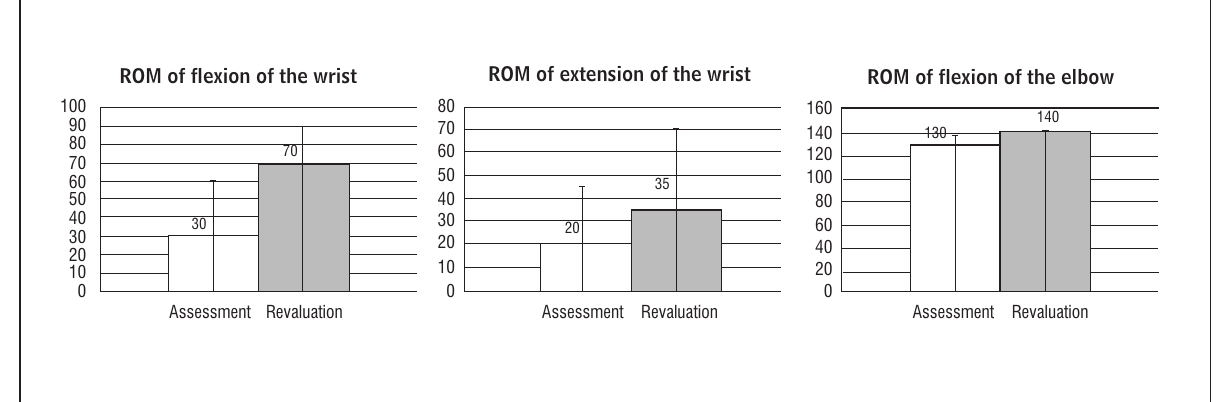
Figure 1 - Medium, maximum and minimum values of range of motion of flexion of the wrist and elbow, and extension of the wrist of patients at 1 st session (evaluation) and 20 th session (revaluation) Source: Research